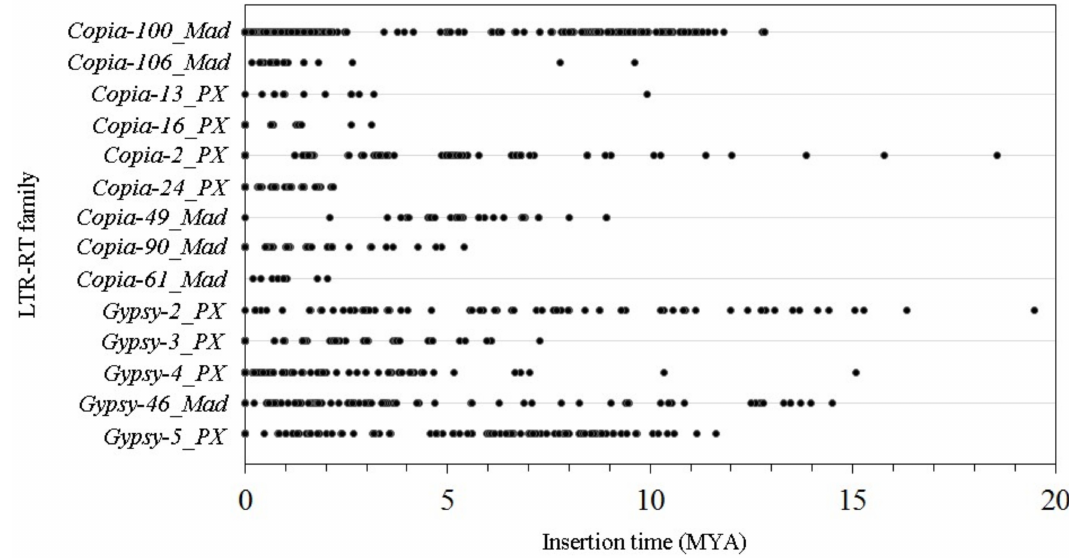
Figure 4. The insertion times of the 14 high-copy-number LTR-RT subfamilies in the ‘Suli’ genome.